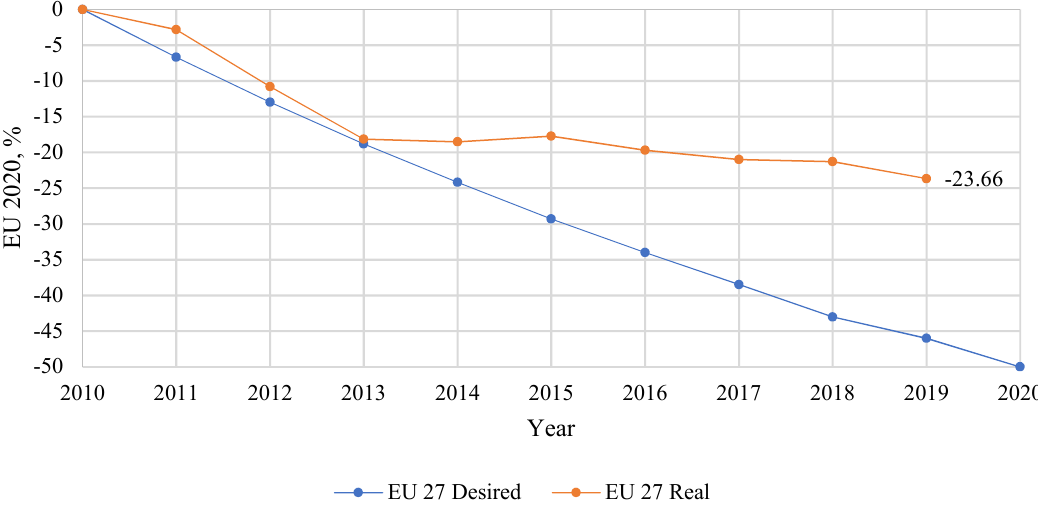
Figure 2. State between actual and desired progress towards the Europe 2020 target [11].